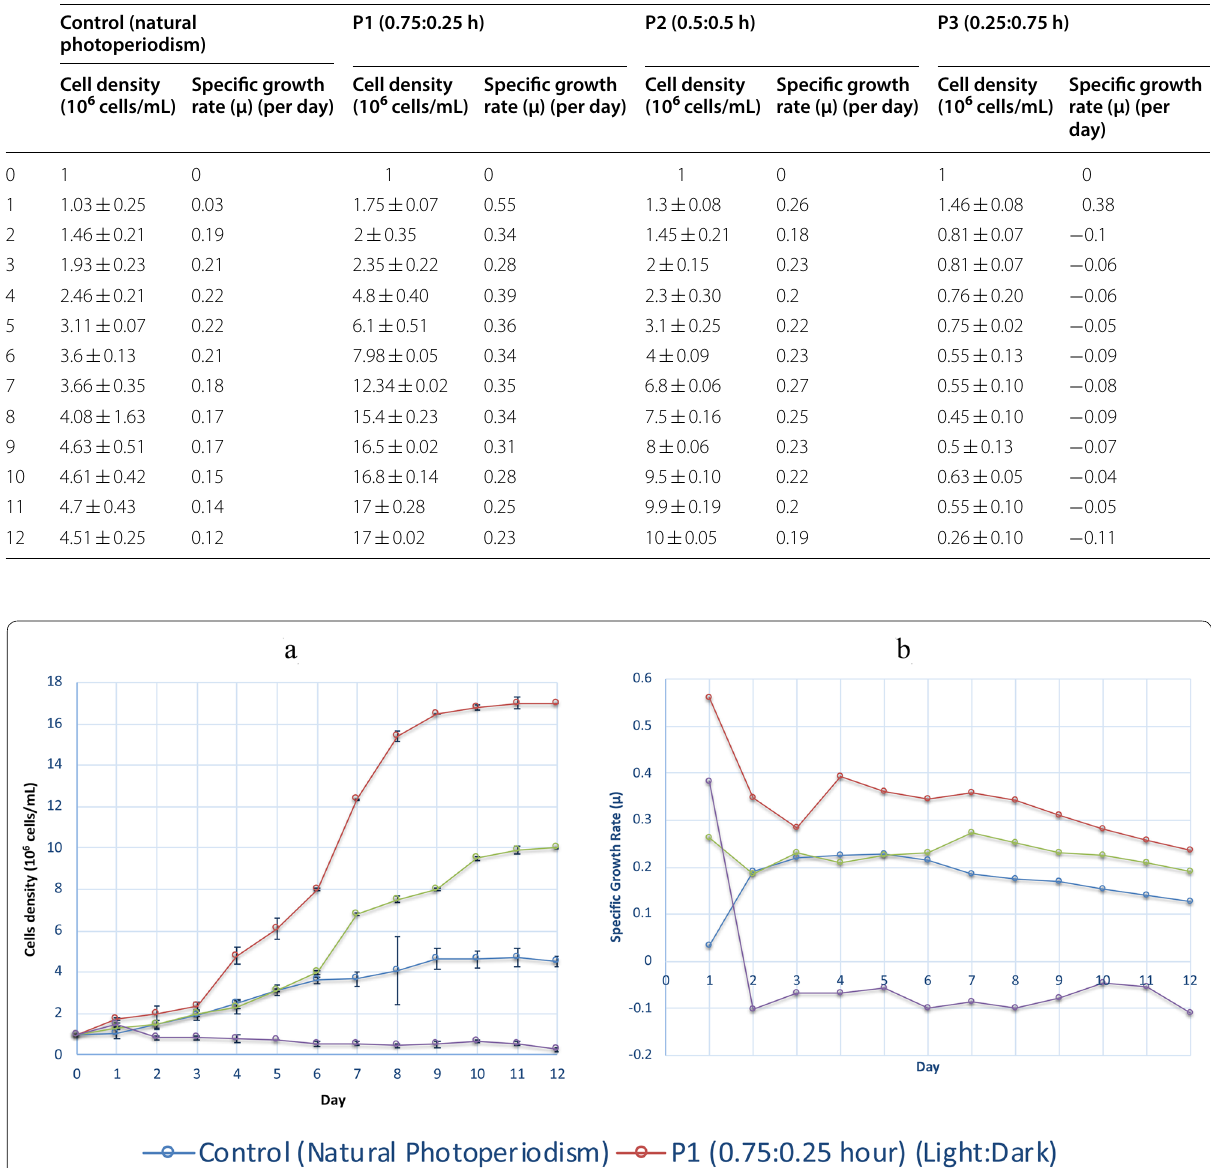
Table 4 Population growth of Nannochloropsis sp. on the flashing light treatment Day Flashing light (light:dark) Control (natural P1 (0.75:0.25 h) photoperiodism)